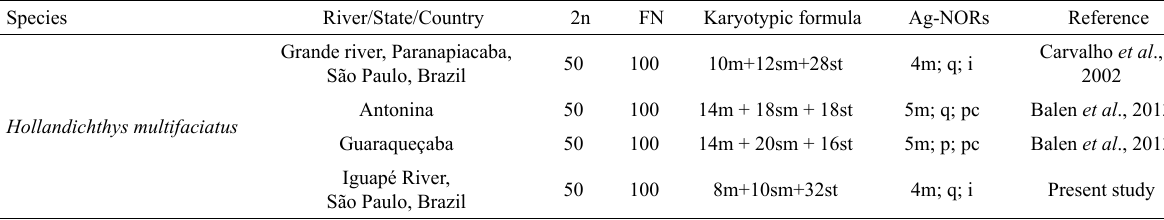
Table 1 ‒ Summary of the karyotypes found in the different samples of Hollandichthys multifasciatus.